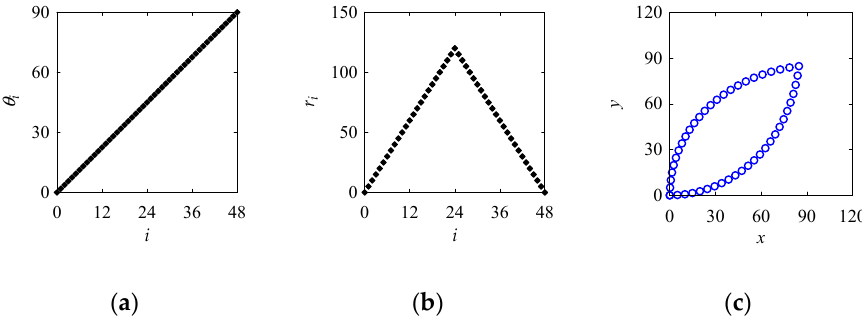
Figure 6. Settings for a leaf-shape using the PCA. ( a ) Input1: θ i ; ( b ) Input2: r i ; ( c ) Output: Point cloud.